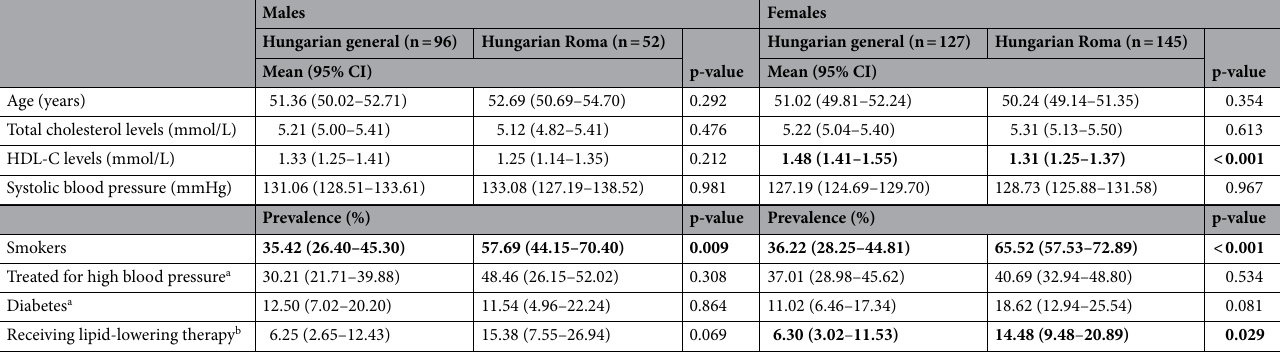
Table 3. Characteristics of 40–64-year-old study populations involved in the calculation of SCORE, PCE and, RPCE by ethnicity and sex. Significant differences in mean or prevalence rates are highlighted in bold. a Not used for SCORE chart calculation. b Not used for risk calculation in any risk assessment models.